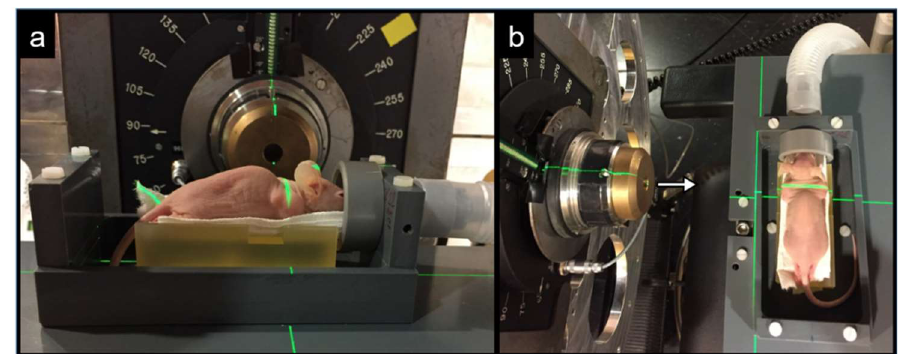
Figure 1. Picture of an anesthetized tumor-bearing mouse positioned on the irradiation platform installed at OPTIS2 at CPT for proton irradiation. ( a ) Frontal view with beam nozzle in the center of the picture and the inhalation anesthesia on the right side. ( b ) Top view with the beam nozzle on the left side and the mouse bed on the right side. Direction of beam is indicated by a white arrow.